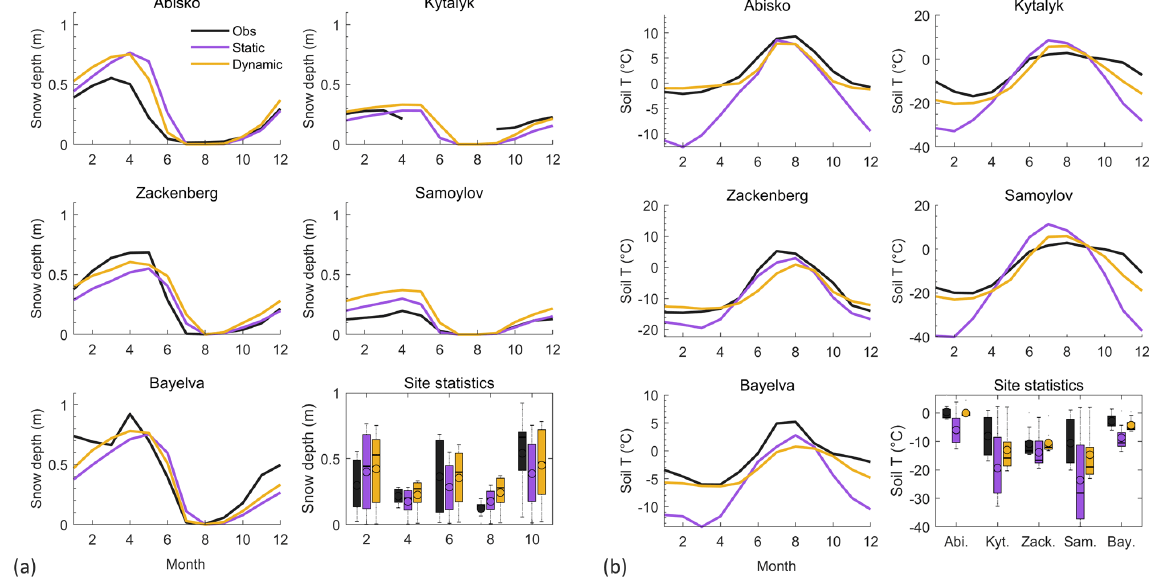
Figure 4. Seasonal cycle of (a) snow depth and (b) soil temperature at 25cm depth for the studied sites, comparing model simulations and observations. Site statistics show the spread of monthly snow depth and soil temperature values for the respective sites – excluding the summer months